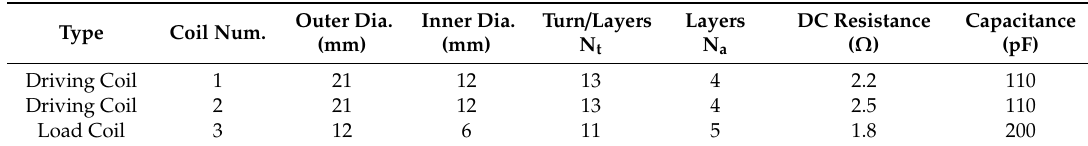
Table 3. Coils’ physical specification by measurements.